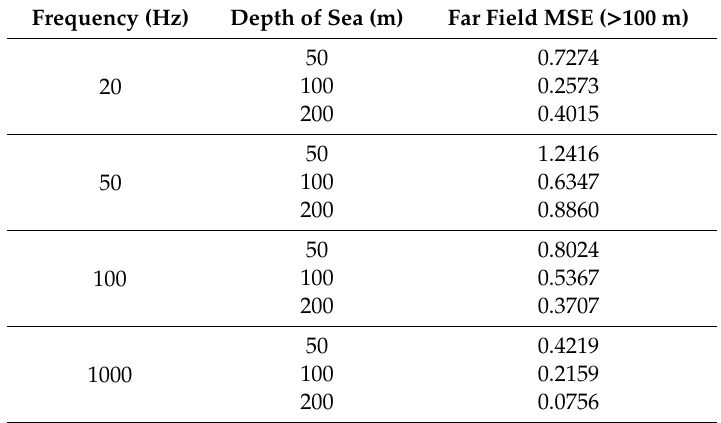
Table 1. MSE of the solution of the ray solution compared to the Green’s function for di ff erent frequencies and di ff erent sea